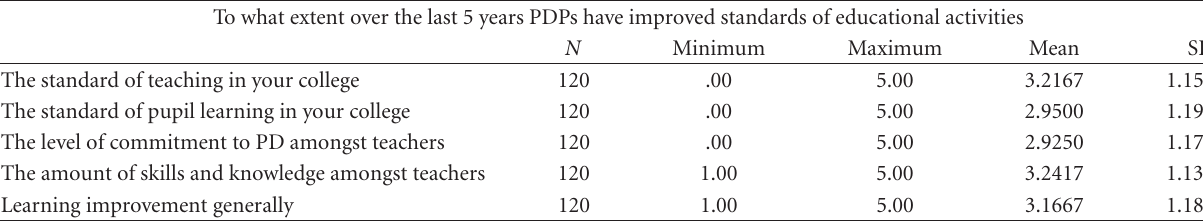
Table 5: Teachers perceptions of PDPs to improve standard of educational activities.